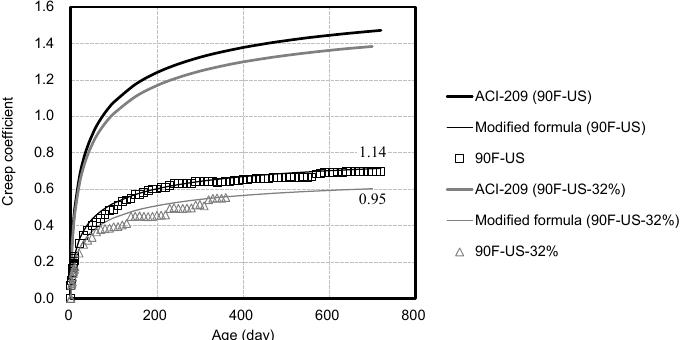
Figure 11. Comparison of compressive creep coefficients based on 40% and 32% load.